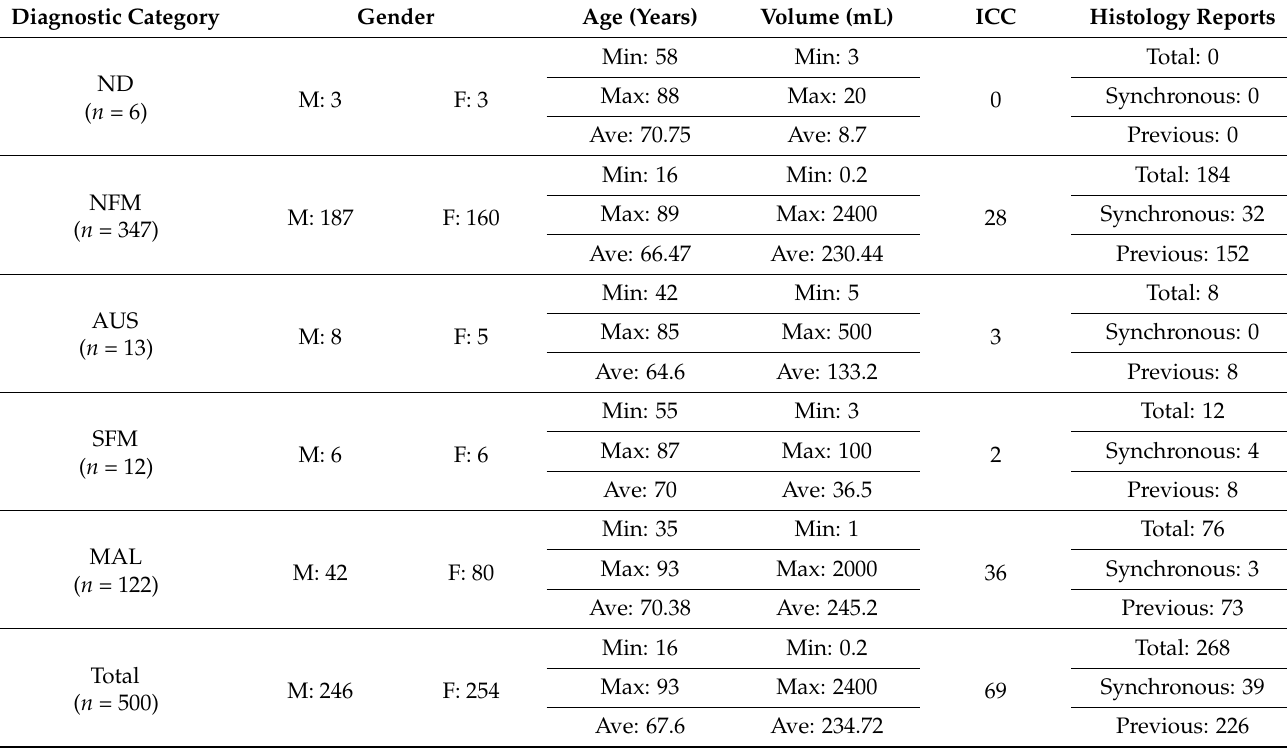
Table 3. Number of peritoneal effusion cases and gender, age, volume, ICC studies and histology report for each TIS